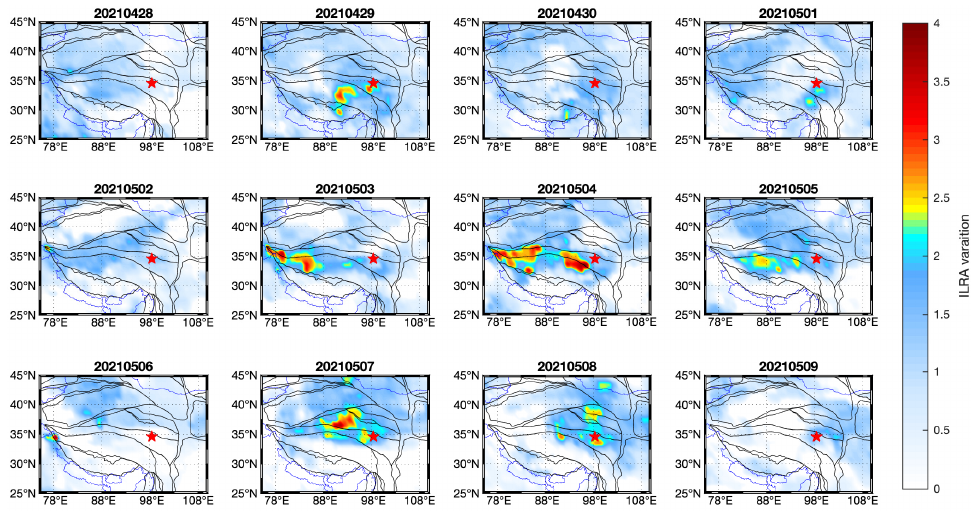
Figure 7. Spatial distribution of ILRA variation prior to the Madoi M 7.3 earthquake. Black lines indicate the boundaries of tectonic blocks, and red stars indicate the epicenter of the Madoi M 7.3 earthquake.